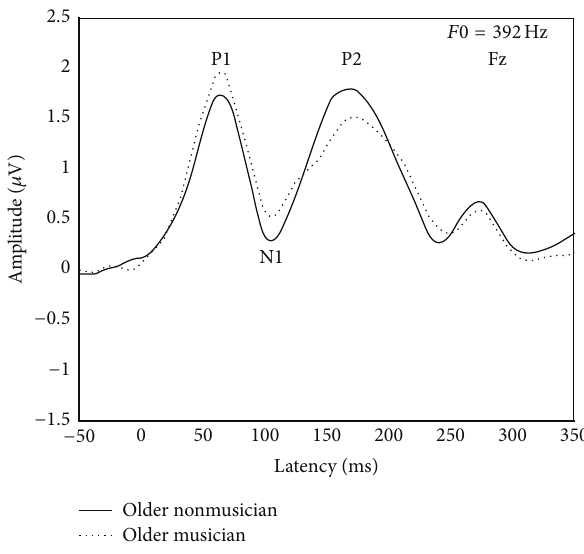
Figure 1: Group averaged CAEP waveforms illustrating P1, N1, and P2 elicited from older nonmusicians (solid line) and older musicians (dotted line) by the standard harmonic tone ( 𝐹0 = 392